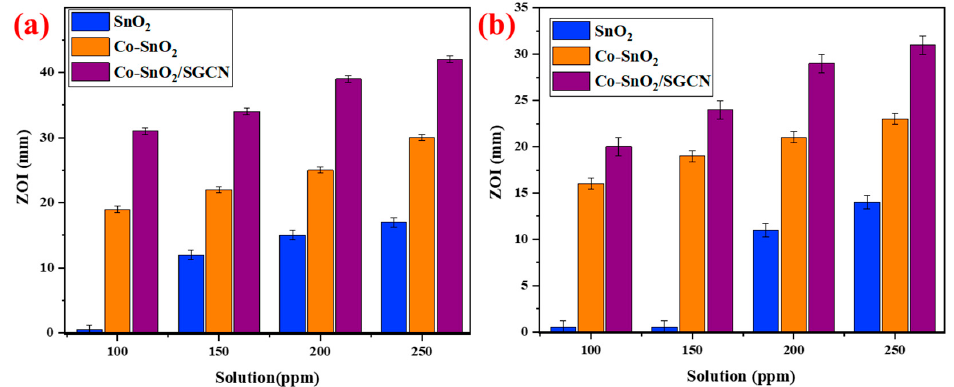
Figure 10. ZOI diameter of SnO 2 , Co-SnO 2 and 7% Co-SnO 2 /50% SGCN against E. coli. ( a ) and B. subtiles ( b ).